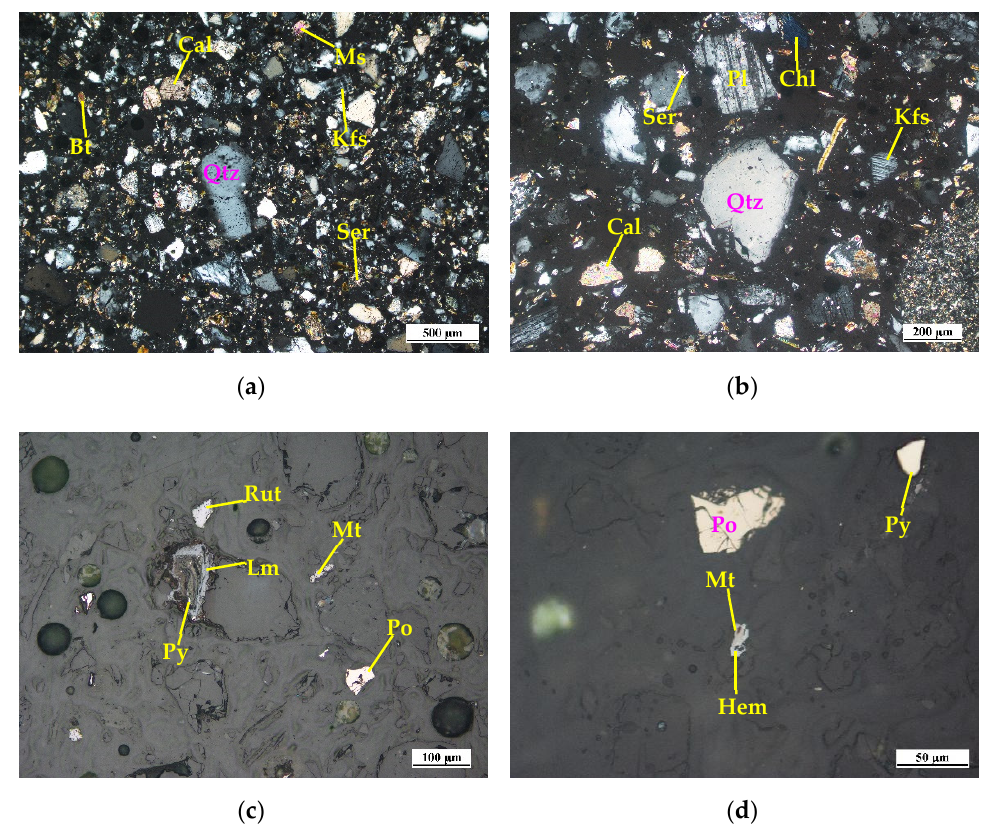
Figure 3. Microscopic photographs of minerals and embedding characteristics of tailings samples.